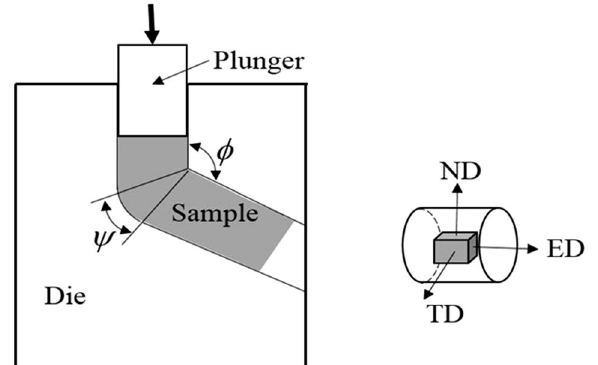
Figure 1. ECAP mold structure